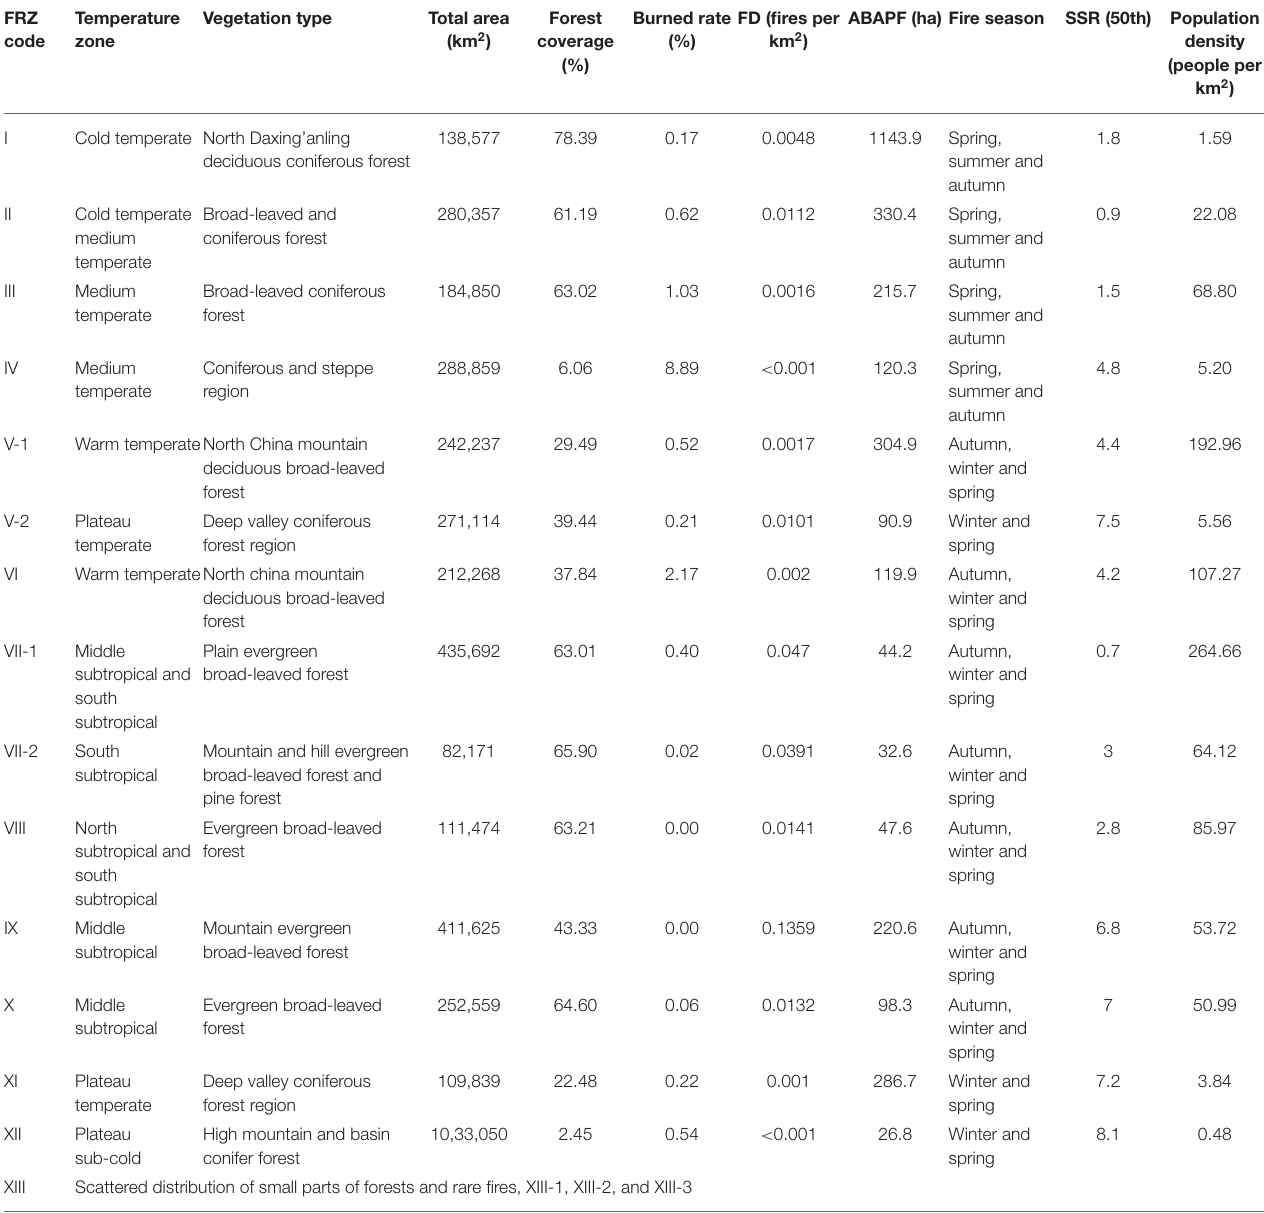
TABLE 2 | Characteristics of each fire regime